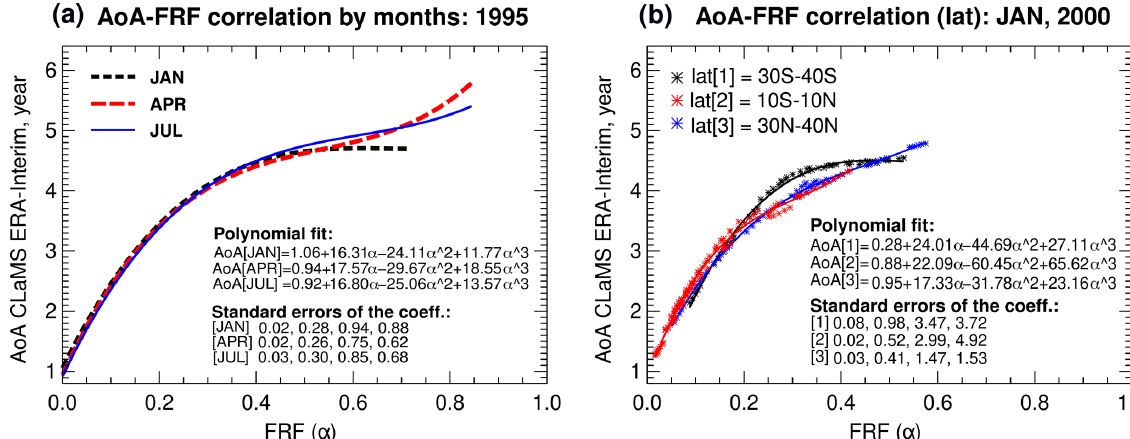
Figure 4. Monthly relationship between FRF from the FULL method and CLaMS AoA. An example of the relationship between estimated FRF (with FULL method) and CLaMS AoA. In panel (a) are shown correlation functions for three months of 1995: January (black dashed line), April (red dashed line), and July (blue solid line); FRF and CLaMS AoA are taken at the whole range of latitudes (90 ◦ S–90 ◦ N). In panel (b) are shown the relationships between estimated FRF and CLaMS AoA for January 2000 for three intervals of latitudes: between 30 and 40 ◦ S (black line and black asterisks), 10 ◦ S–10 ◦ N (red line and red asterisks), and 30–40 ◦ N (blue line and blue asterisks). The estimated FRF and CLaMS AoA driven by ERA-Interim (zonally averaged) are taken between 450 and 1000K, where FRF has positive values, in both panels. The AoA–FRF relationships are shown by monthly fitting a third-order polynomial function; in (a) the actual AoA–FRF distribution is not shown to avoid an overcrowded plot.